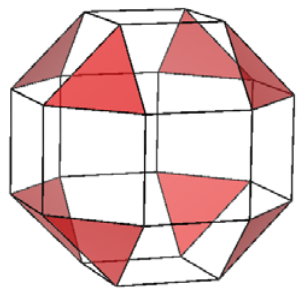
Figure 9. Rendering of an Archimedean solid with a Rhombicuboctahedron structure. The triangular facets are highlighted in